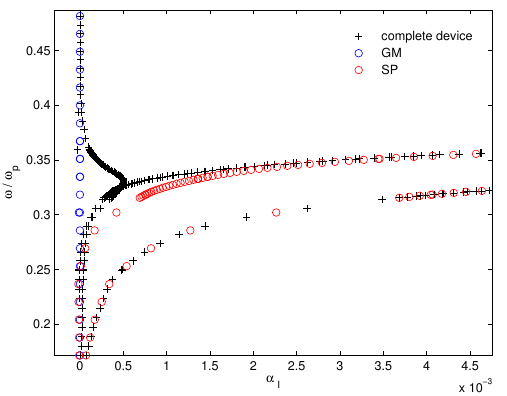
Figure 4: Loss diagram for a thickness e = 98 nm : the nor- malized frequency (to the plasma frequency ω p ) in function of the imaginary part of α . Separately, the absorption of each mode is in blue and red.